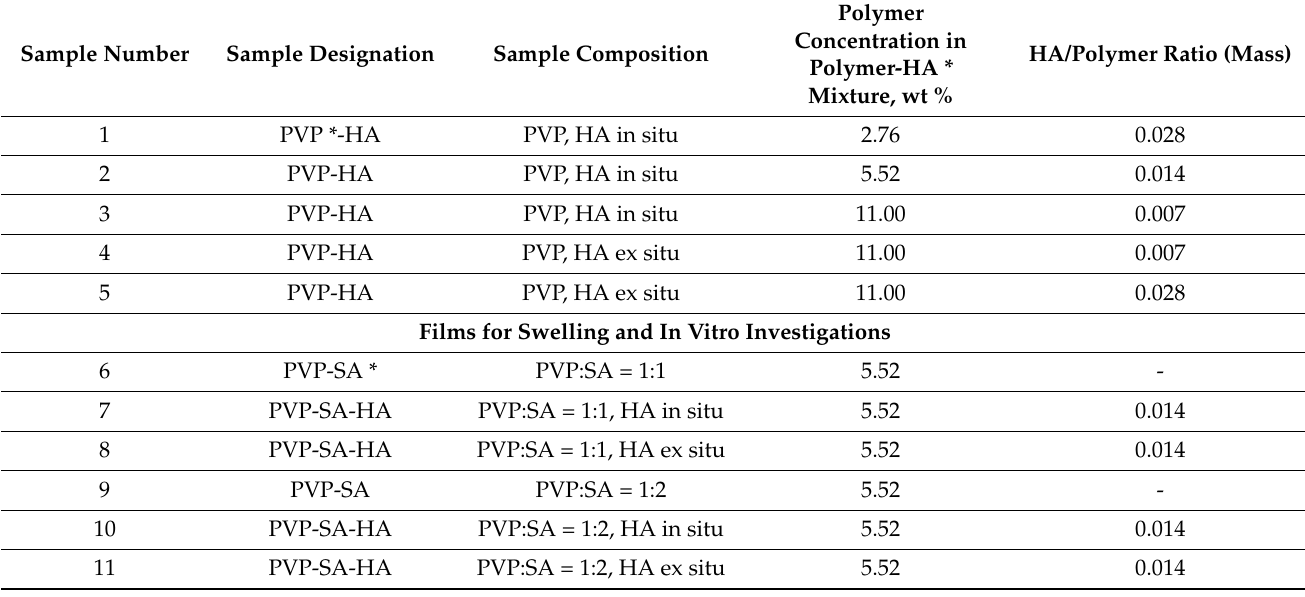
Table 1. Materials based on PVP with SA and